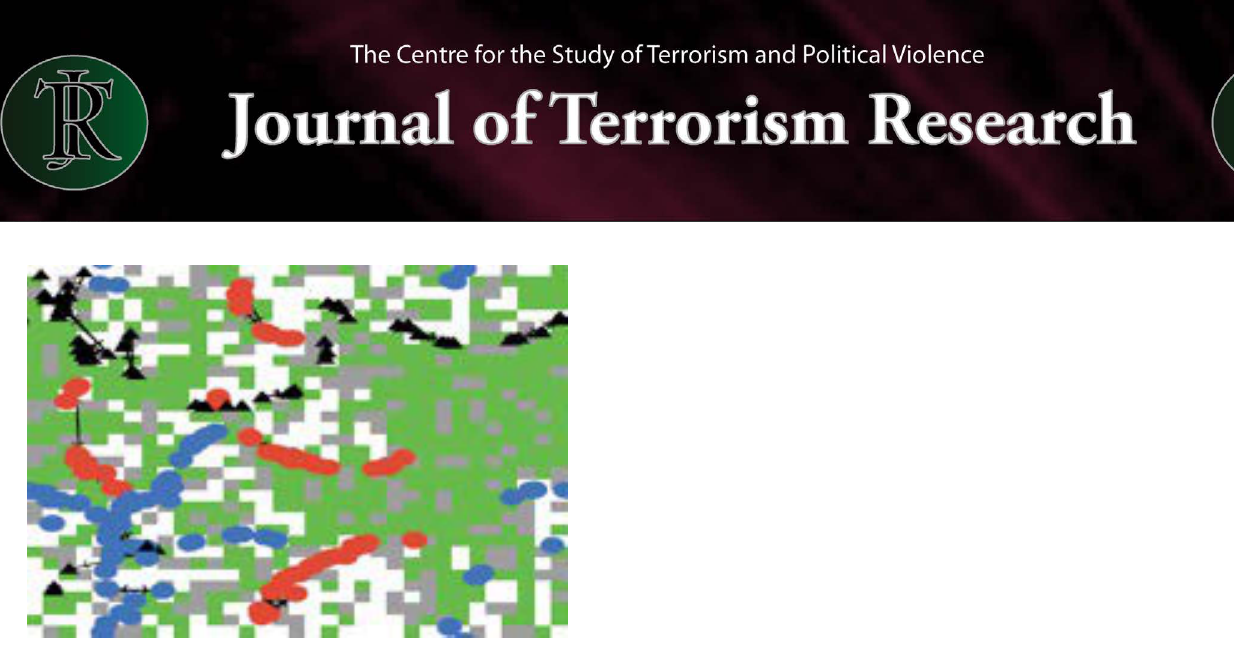
Figure 3. Some agents commit (A